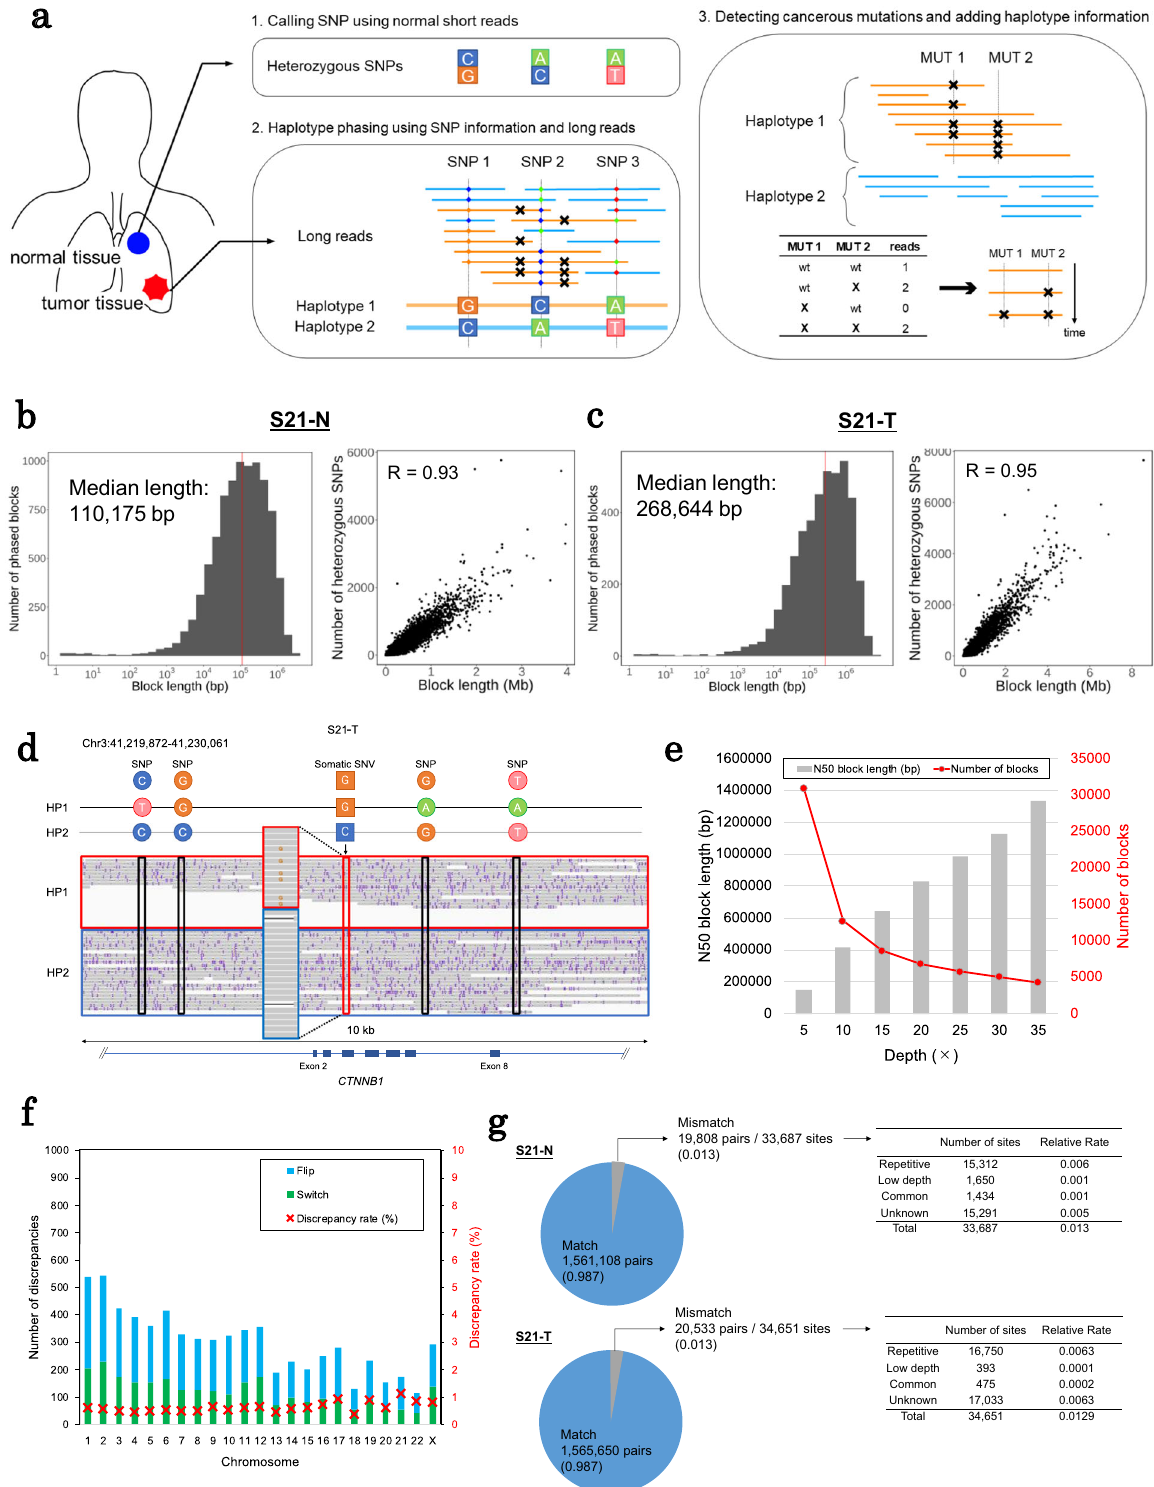
haplotypes obtained from 418 healthy individuals, as identi fi ed from the short read WGS data. The comparison showed that 98.7% of the SNP – SNP associations were consistent (Fig. 1g). These results indicate that the obtained phasing information from both tumor and normal genomes are reasonably precise and can be used as references for performing further analyses of the genomic mutations at the haplotype